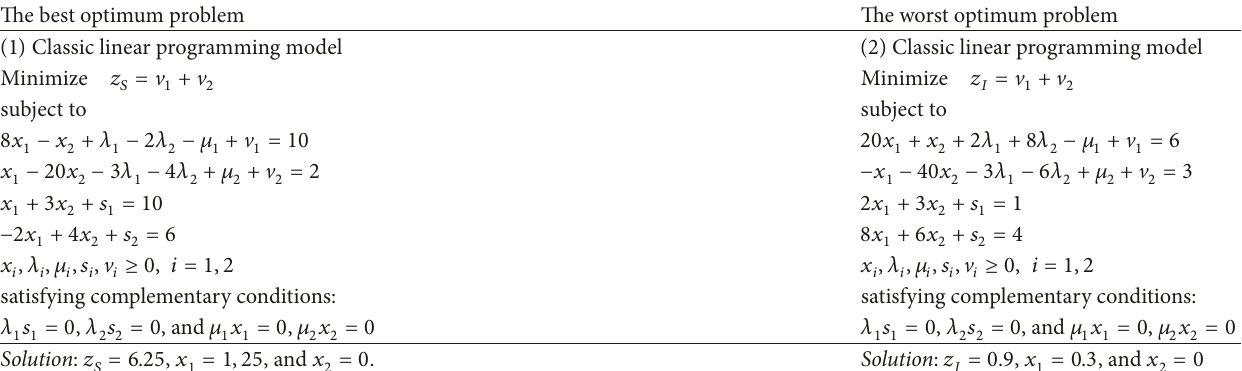
Table 1: Two classic linear programming models with special